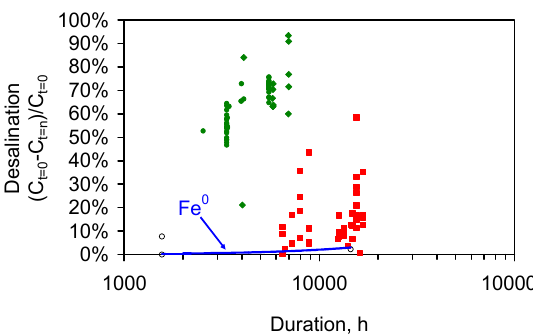
Figure B1. Desalination associated with ZVI pellet desalination. Type A catalysts (ST and MT). ST Series trials = Green markers; MT Series Trials = Red Markers. Blue regression line is for control trials of Fe 0 placed in saline water. n = 104; operating temperature, non-isothermal varying with atmospheric temperature over the range − 15 °C to 20 °C; reactor size, variable, 0.2 to 10 L, ZVI concentration = 5 to >100 g/L [16]. Details of the ST and MT series trials are provided in Reference [16]. C t = 0 = initial concentration; C t = n = concentration at time t = n. Throughput scale up required to achieve 20 m 3 /day, for t = 200 days (4800 h) is between 400,000 and 20,000,000.